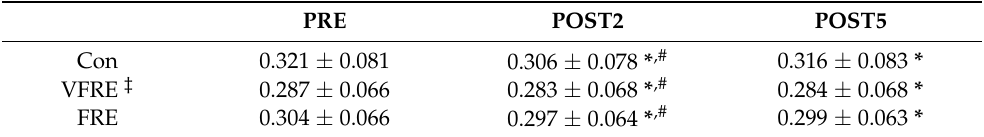
Table 3. The GCT of DJ (s); mean ± SD +